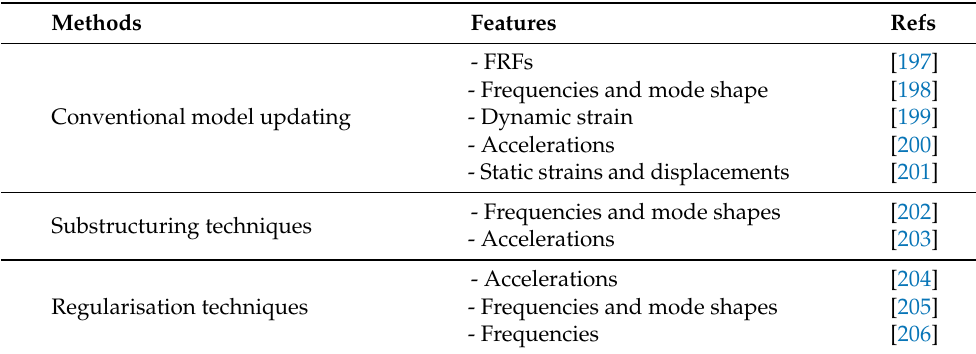
Table 15. Different types of features employed in some recent model-updating techniques for damage detection of composite